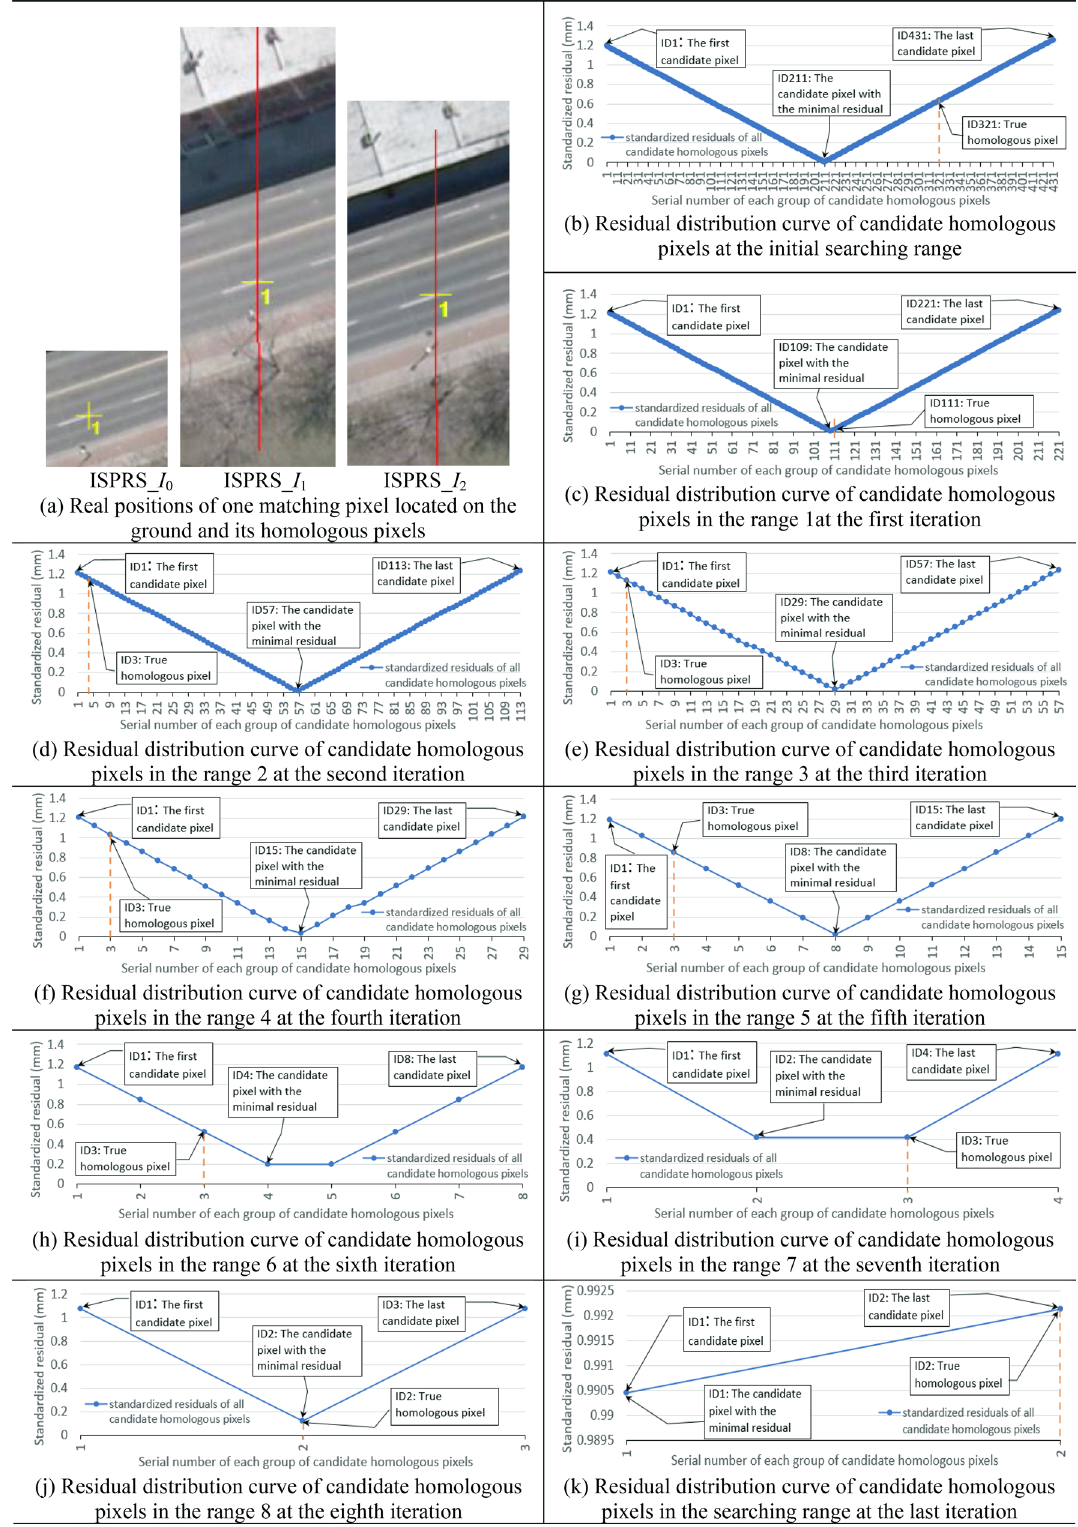
Figure 9. The experimental results of positional distribution form among candidate homologous pixels for one matching pixel located on the ground in ISPRS experimental images ISPRS_ I 0 -ISPRS_ I 1 -ISPRS_ I 2 (Graphs in (b) to (k) were created by Microsoft Excel